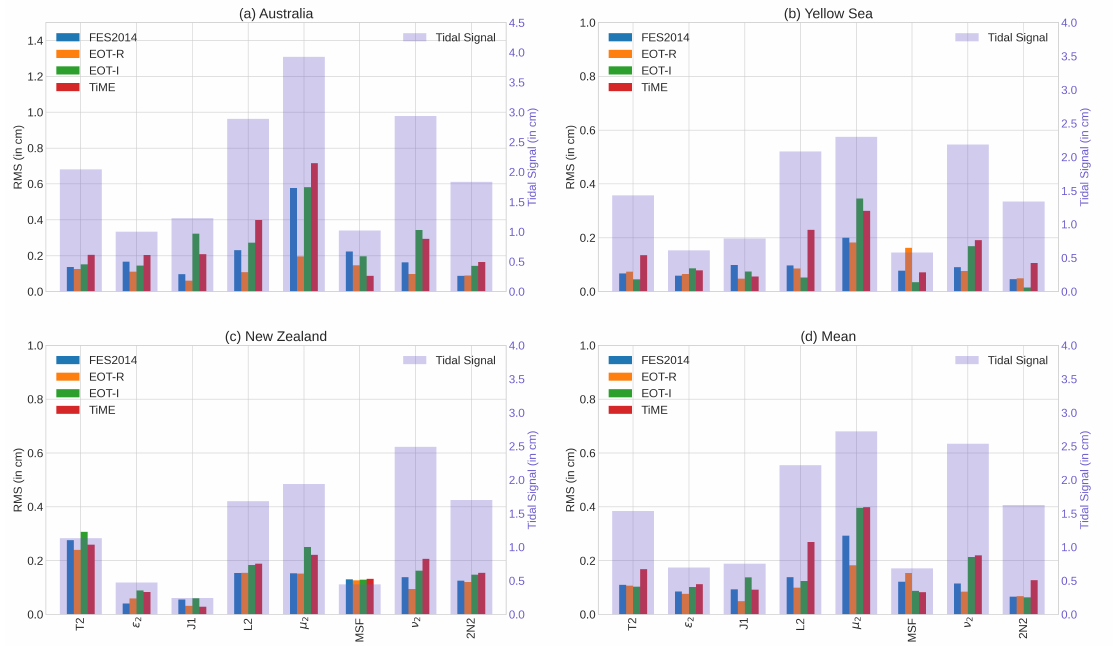
Figure 4. The RMS, in cm, of the minor tides from all three regions for the EOT-R, EOT-I, FES2014, and TiME tide models. The RMS is overlaid above the tidal signals (blue axis) of each individual constituent in each of the regions. The number of tide gauges for each region is 27 for Australia, 65 for the Yellow Sea, and 12 for New Zealand, with the mean being of all 104 tide